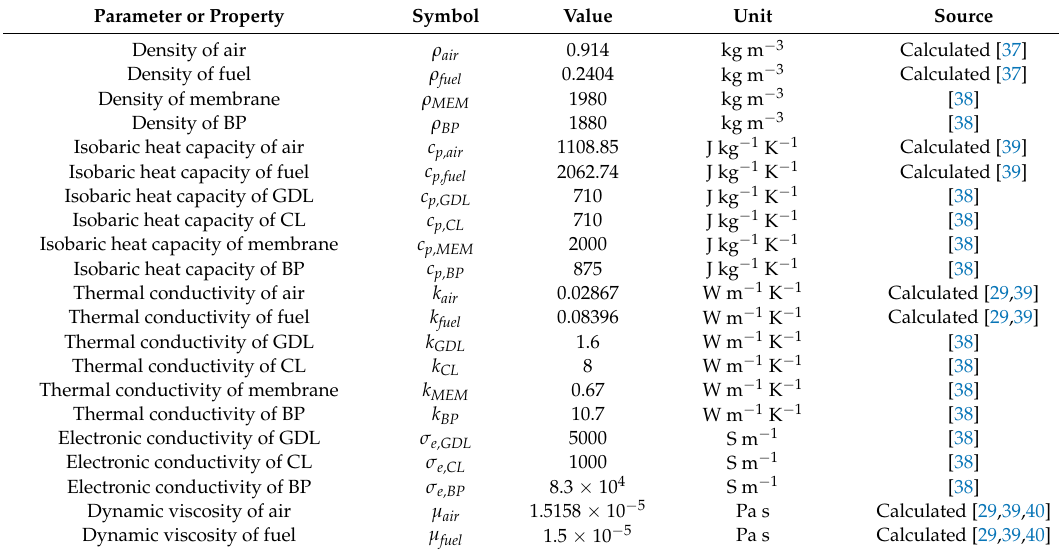
Table 4. Physical constants and properties at 353 K.